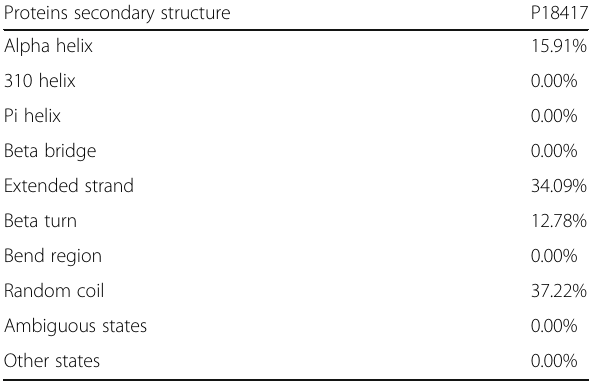
Table 5 Secondary structure prediction by SOPMA